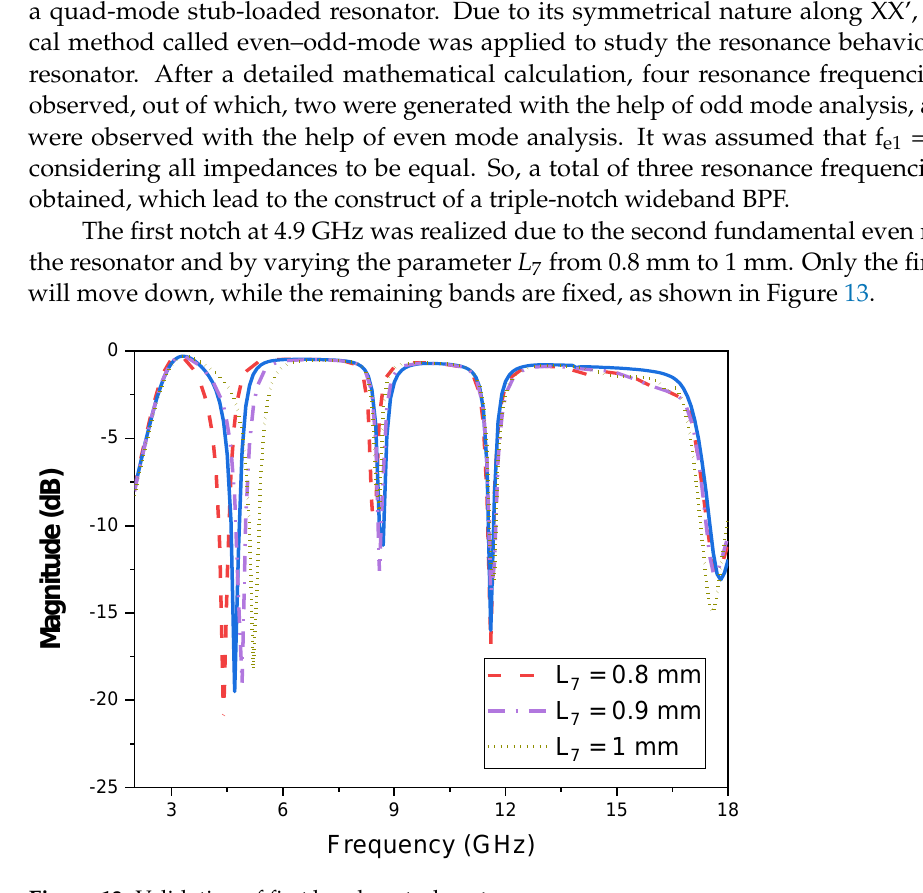
L 4 = 7 mm L 4 = 8 mm Figure 14. Validation of second band control w.r.t L 4. The third stopband at 11.5 GHz was realized due to the first even mode of the reso- nator, as derived in Equation (6). In Figures 15 and 16, only the third band is changed widely by changing the lengths L 5 and L6, while the other two bands almost remain con- stant. Moreover, all the stopbands are simultaneously decreased with the parameter L 8 from 2.4 mm to 2.8 mm, as shown in Figure 17. This is because the parameter L 8 is present in all the resonance equations, as derived above.